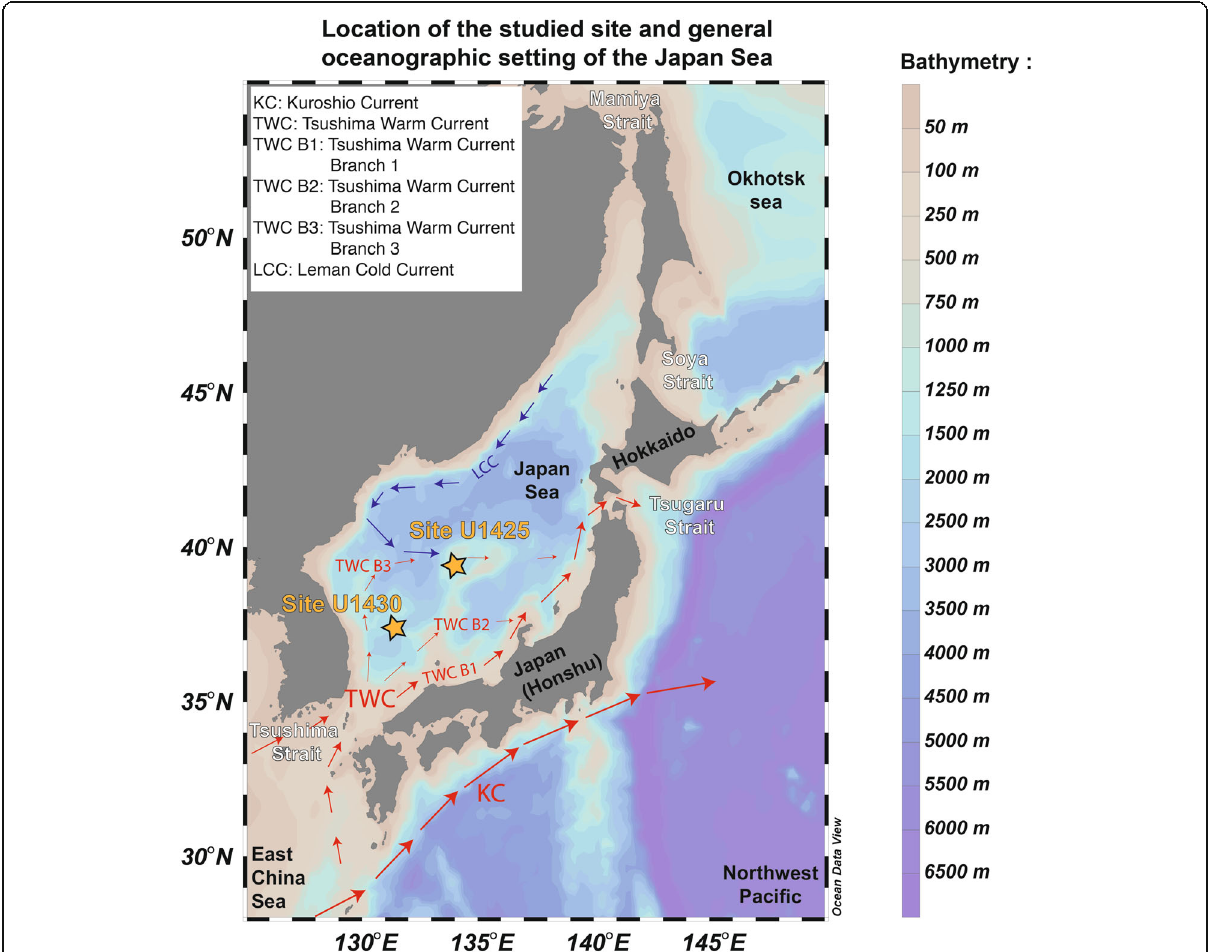
Fig. 1 Location of the study sites and the local oceanographic setting of the Japan Sea. The map was generated by the software Ocean Data View 4 of Schlitzer